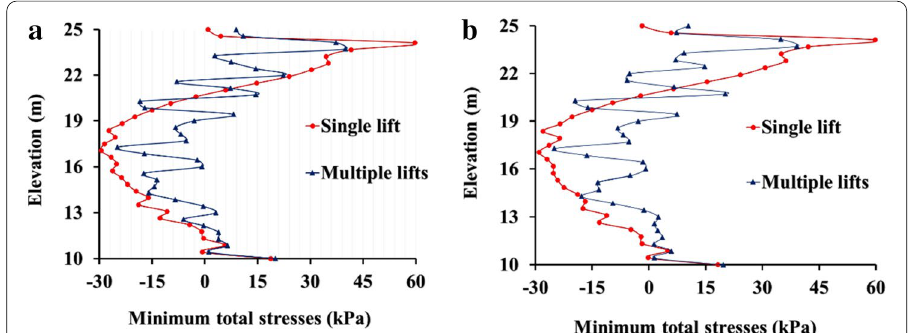
Fig. 7 Variation of minimum total stress along the dam faces just after the completion of construction a Upstream face, b Downstream